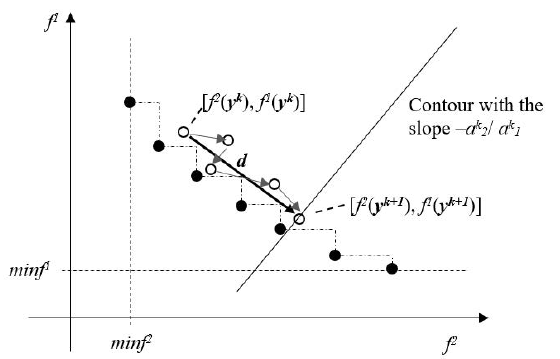
Figure 3. The black circles correspond to the Pareto front members, and the empty circles denote the solutions met during the minimization process in the direction d .